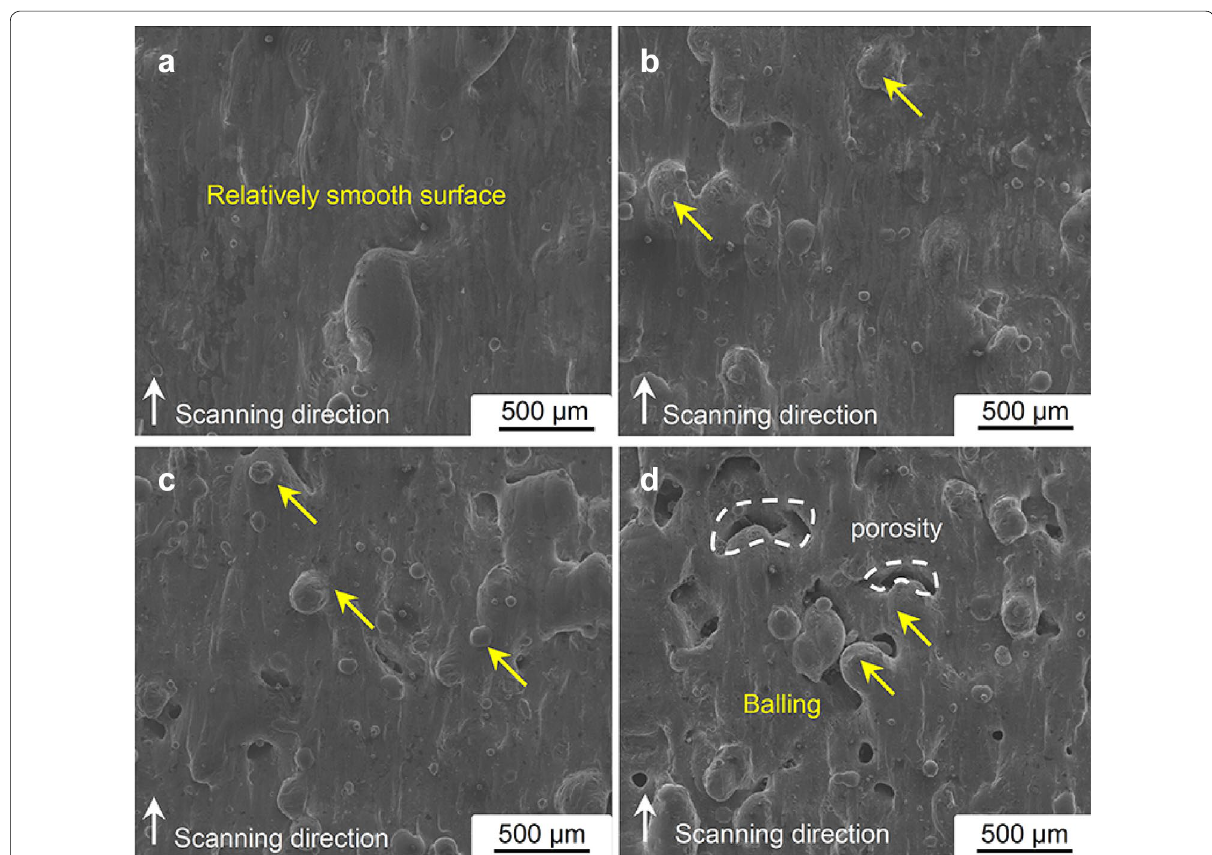
Figure 4 The typical FE-SEM images showing the surface morphologies of SLM-processed TiB 2 /AlSi10Mg composite parts fabricated by various scan speeds ( P 400 W): a v 2000 mm/s; b v 2400 mm/s; c v 2800 mm/s; d v 3200 = = = = =